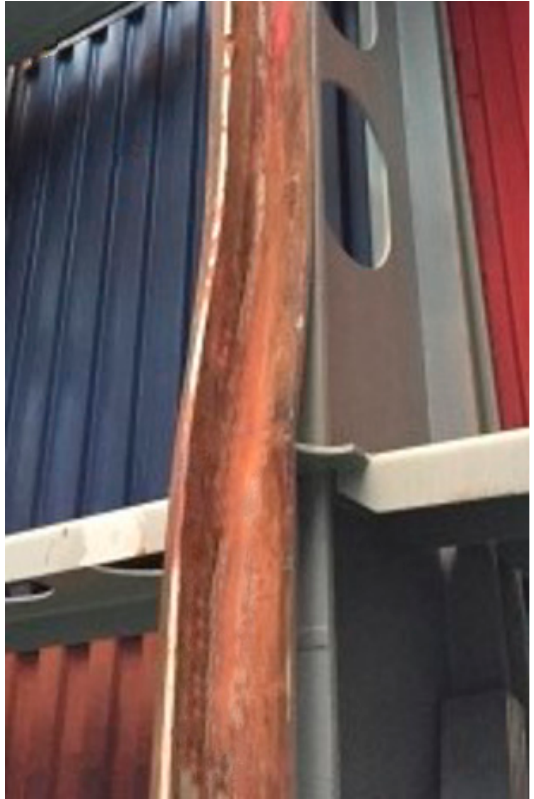
Figure 1. Example of a damaged VCG.